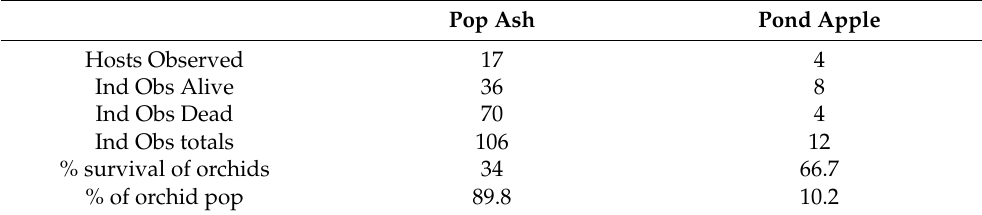
Table 1. Observed Campylocentrum pachyrrhizum individuals on host tree species. The C. pachyrrhizum found on A. glabra (pond apple) had a higher survivorship rate, but the F. caroliniana (pop ash) was found to host a majority percentage of the population. Pop Ash Pond Apple